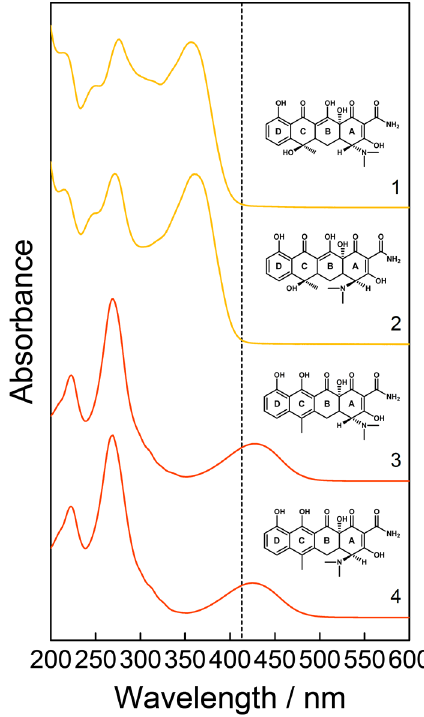
Figure 1. Schematic chemical structures and absorption spectra of a 0.1 mM aqueous solution of tetracycline (TC, 1) and its impurities 4-epitetracycline (ETC, 2), anhydrotetracycline (ATC, 3), and 4-epianhydrotetracycline (EATC, 4). The applied laser excitation wavelength λ exc = 413 nm is depicted as vertical short-dashed line. This wavelength can be tuned into the electronic absorption band of the chromophores of (E)ATC, where strong resonance Raman enhancements can be achieved for the vibrational modes that are coupled to these electronic transitions. This resonance e ff ect can be exploited for the sensitive detection of these